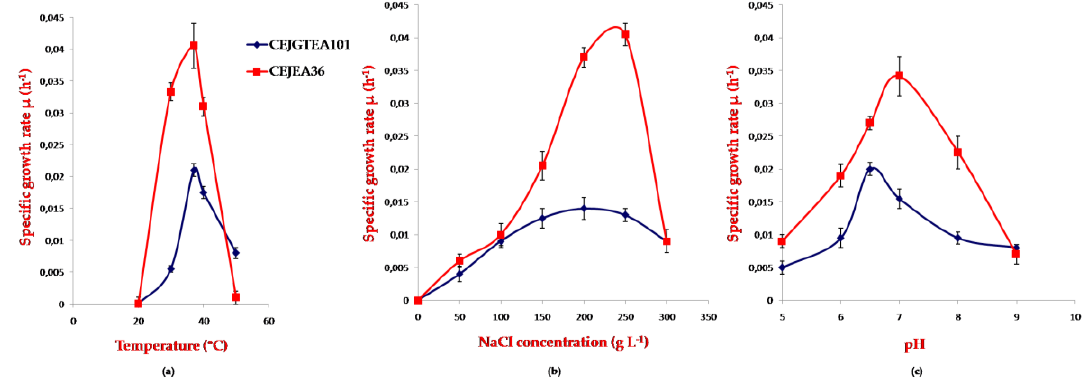
Figure 2. Effects of ( a ) temperature, ( b ) varying salinity, ( c ) pH on growth of strains CEJGTEA101 and CEJEA36 in polyhydroxyalkanoate (PHA)-accumulating medium. Data are shown as means of duplicate with their standard errors. µ: specific growth rate.